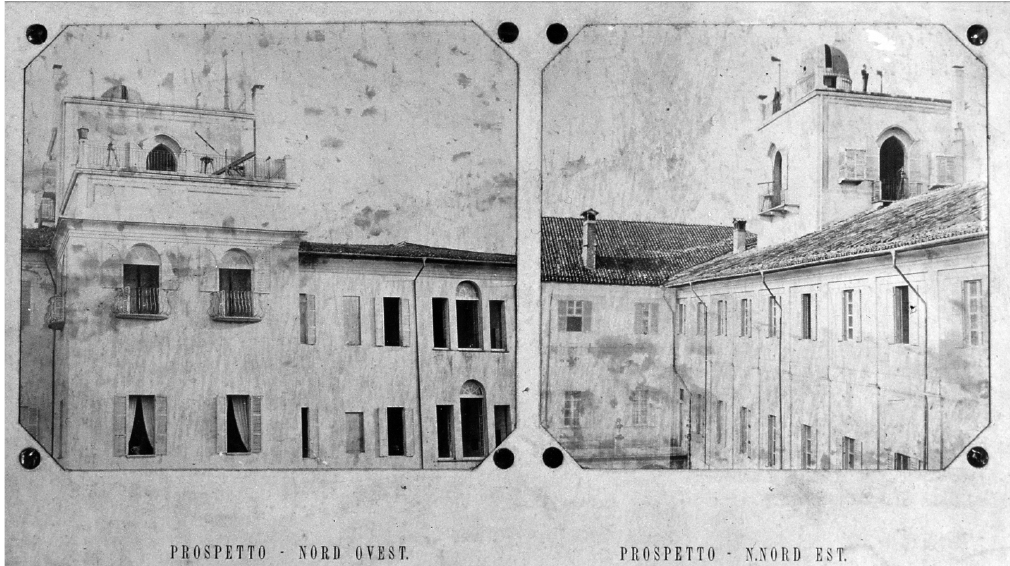
Fig. 1. The Alberoni Observatory in a photograph of the end of 19th century (Archive of the Ufficio Centrale di Ecologia Agraria, Rome).